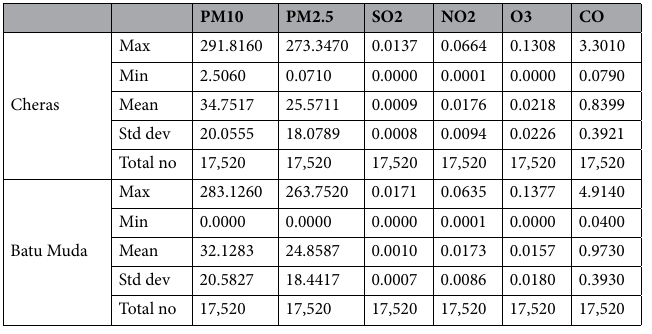
Table 1. Description of datasets